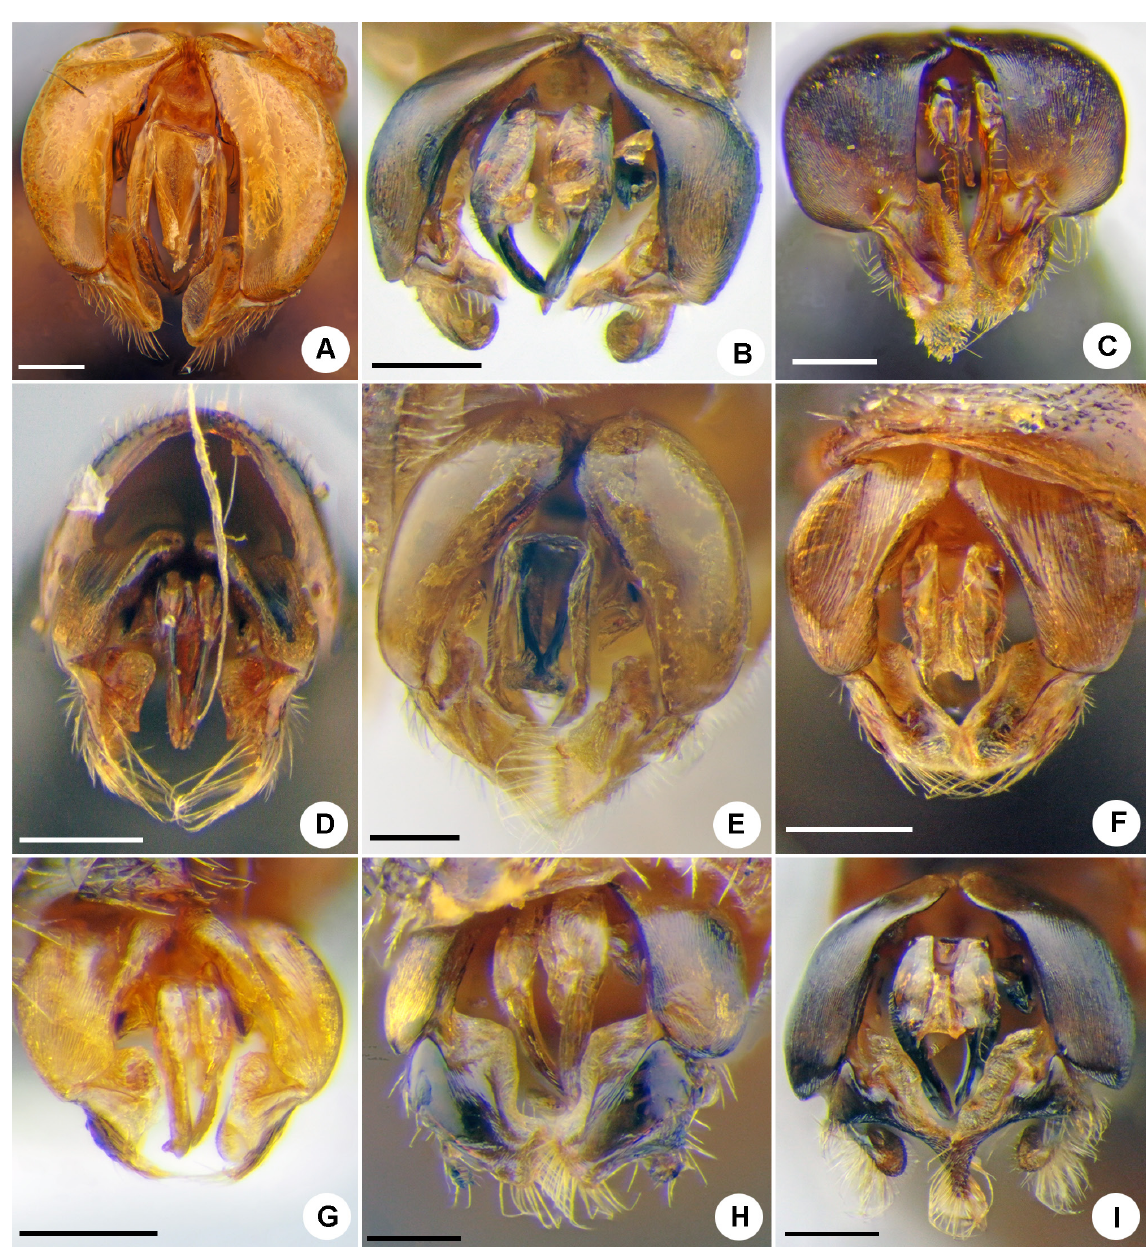
Fig. 3. Genitalia in dorsal view, males. A . Sphecodes fumipennis Smith, 1853. B . S. monilicornis (Kirby, 1802). C . S. montanus Smith, 1879. D . S. hakkariensis Warncke, 1922. E . S. albilabris (Fabricius, 1793). F . S. intermedius Blüthgen, 1923. G . S. simlaensis Blüthgen, 1924. H . S. rufiventris (Panzer, 1798). I . S. gibbus (Linnaeus, 1758). Scale bars = 0.25